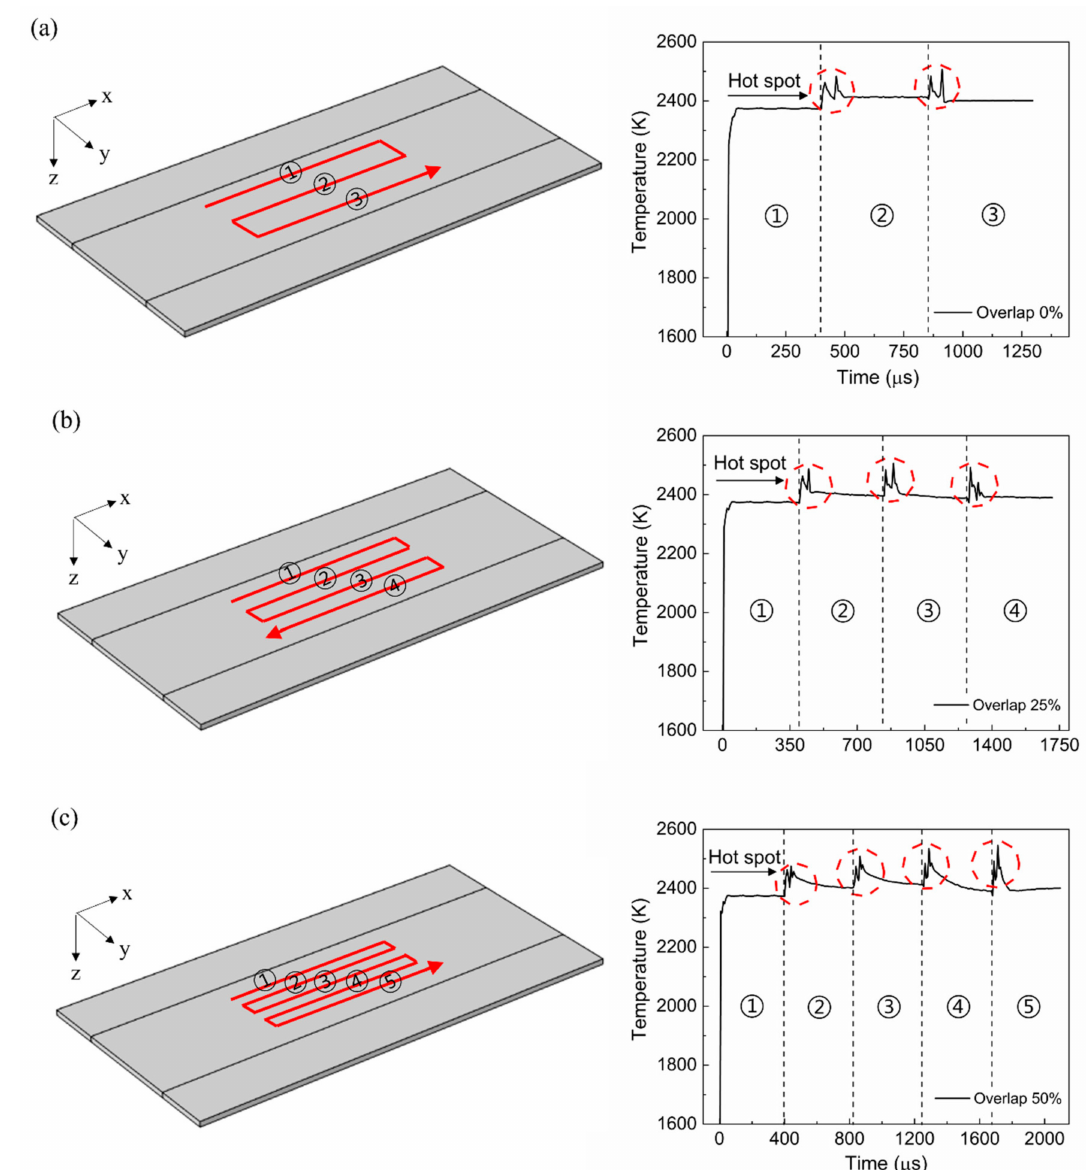
Figure 5. Schematic of the laser scan path and temporal profile of the surface temperature: ( a ) 0% overlap, ( b ) 25% overlap, and ( c ) 50%